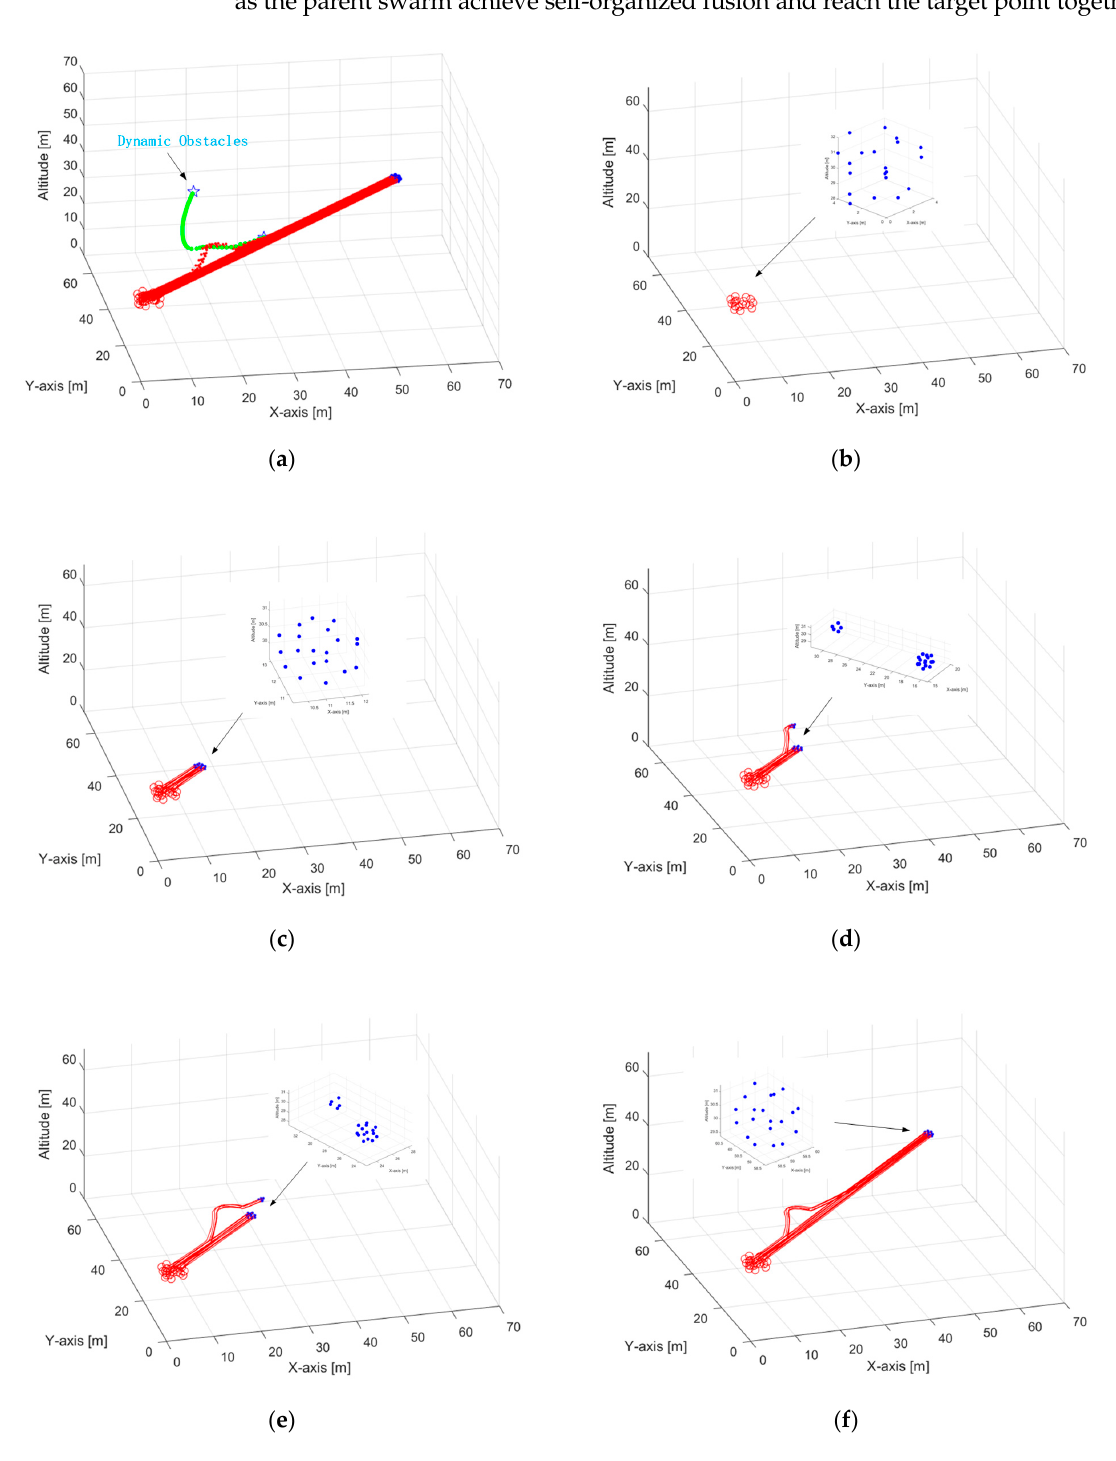
Figure 3. Fission–fusion process of the UAV swarm without anti-catch mechanism. ( a ) the process of the complete UAV swarm fission–fusion; ( b ) the initial state of the UAV swarm; ( c ) the swarm quickly forms a stable swarm state; ( d ) the swarm performs fission movement and traps dynamic obstacles; ( e ) the subs-warm completes its trapping movement and starts to return to the parent swarm; ( f ) the sub-swarm fusion with the parent swarm.